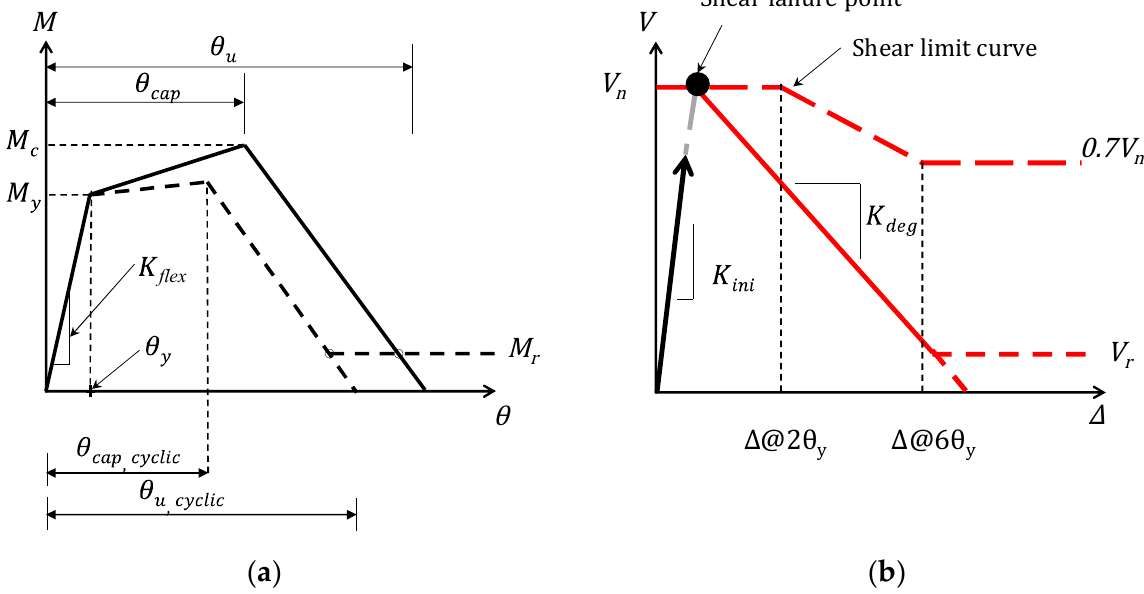
Figure 4. Modelling backbone adopted for the simulation of the pure flexural response spring (no shear spring associated) ( a ) and the pure shear response spring (no rotational spring associated) ( b ).